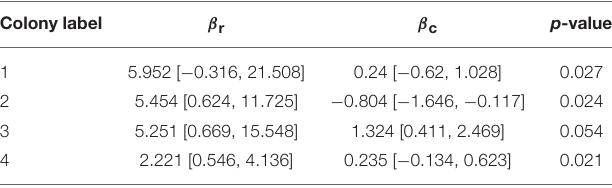
TABLE 2 | Rate regression model fit parameters and